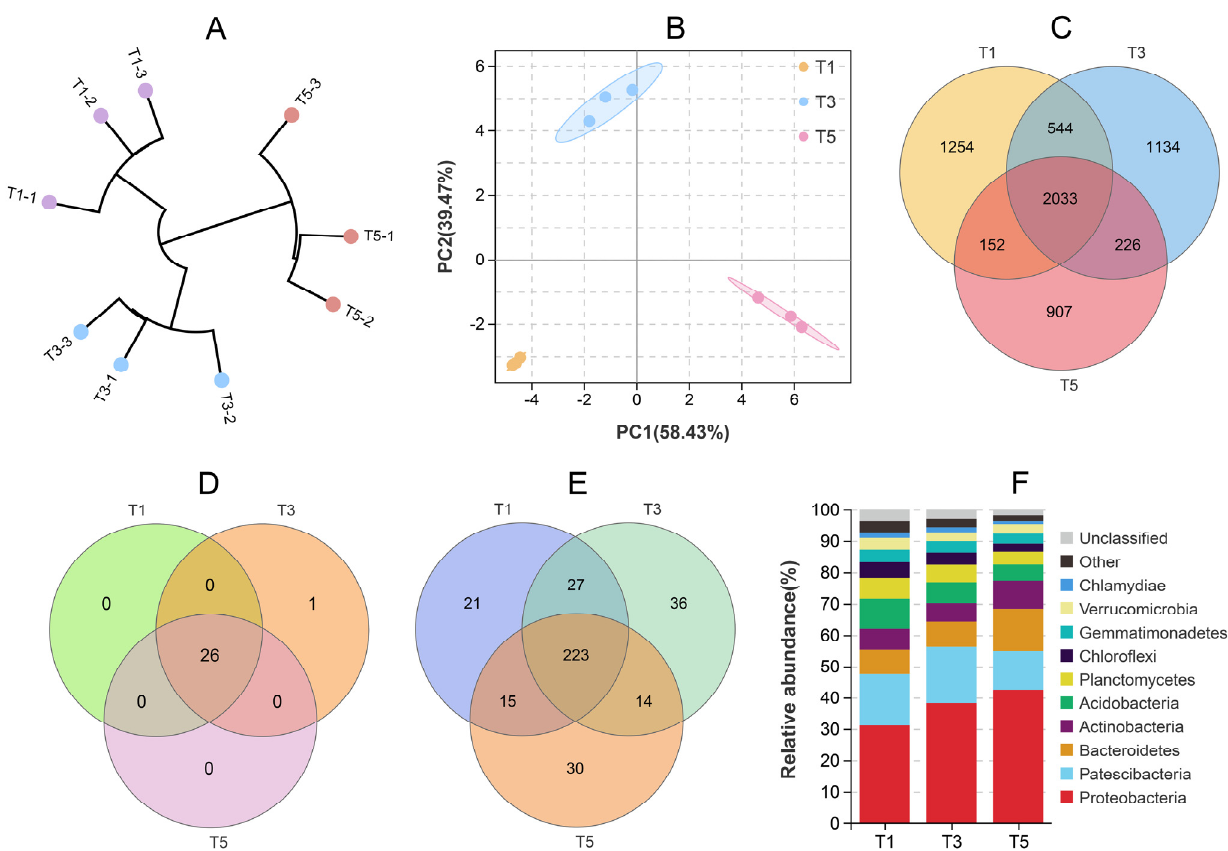
Figure 3. The rhizosphere bacterial community composition of C. grandiflora grown in Cd-contaminated soils supplemented with 0 (T1), 2 (T3), and 8 (T5) g kg − 1 GABA. The unweighted pair group method with arithmetic mean clustering tree ( A ) and principal component analysis ( B ) of samples at the operational taxonomic unit (OTU) level. ( C ) Venn diagram of OTUs among different soils. ( D ) Venn diagram of bacterial phyla among different soils. ( E ) Venn diagram of bacterial genera among different soils. ( F ) Stacked diagram showing the relative abundance of the top ten bacterial phyla in different soils.